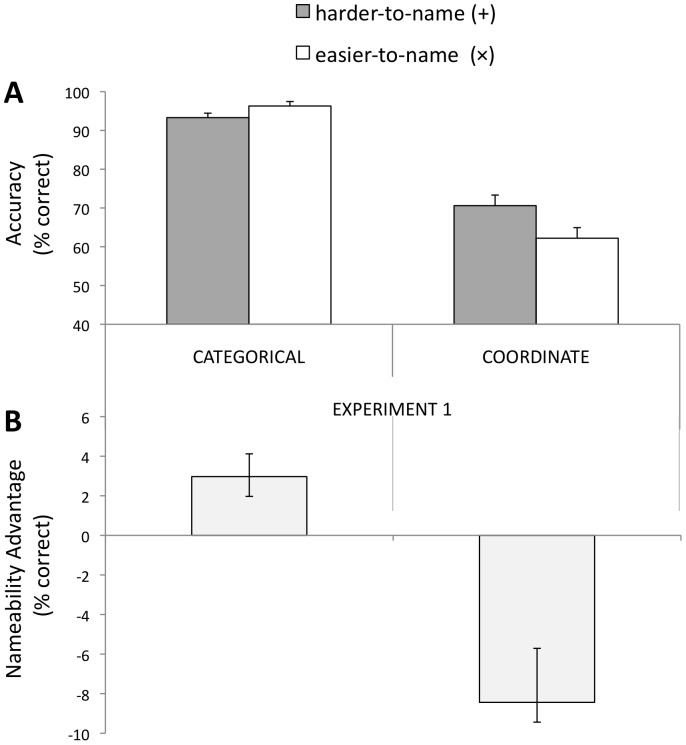
Accuracy results for Experiment 1.(A) Overall % accuracy for all different trials. (B) Nameability advantage (easier-to-name trials minus harder-to-name trials). A positive difference score indicates an advantage on easier-to-name trials; a negative score indicates a disadvantage on easier-to-name trials. Error bars represent 1SE of the mean difference between easier-to-name and harder-to-name trials.